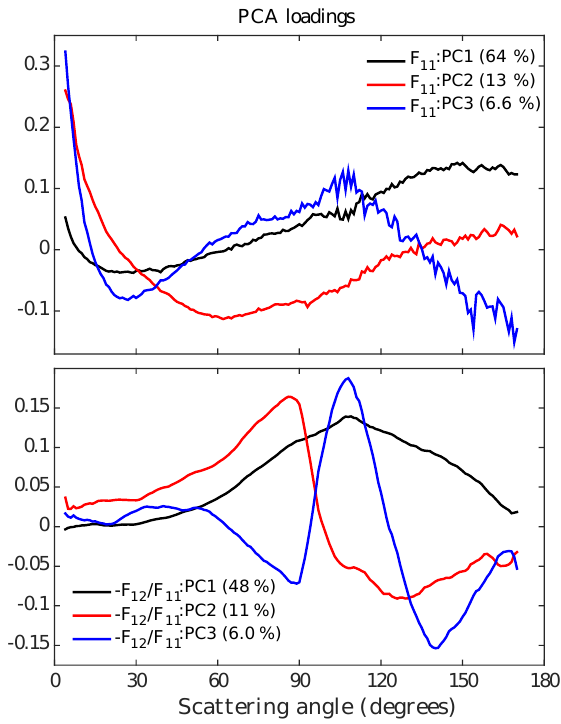
Figure 5. The resulting PCA loadings of the first three principal components from both the e F 11 and − F 12 /F 11 data. The percentage of the data’s variance explained by a given component is shown in parentheses.